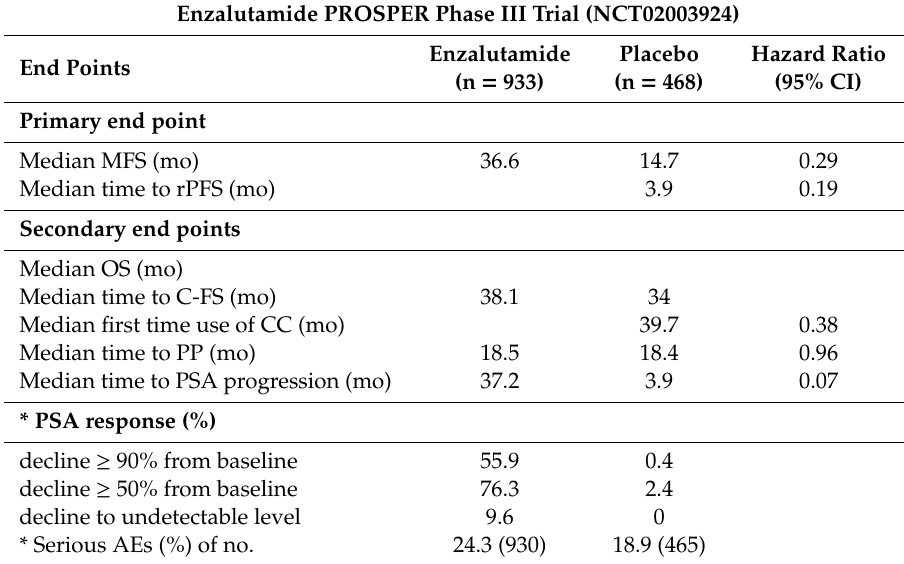
Table 5. Major therapeutic benefits brought by enzalutamide based on